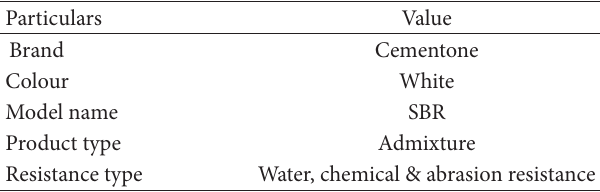
Table 3: Styrene butadiene rubber properties.